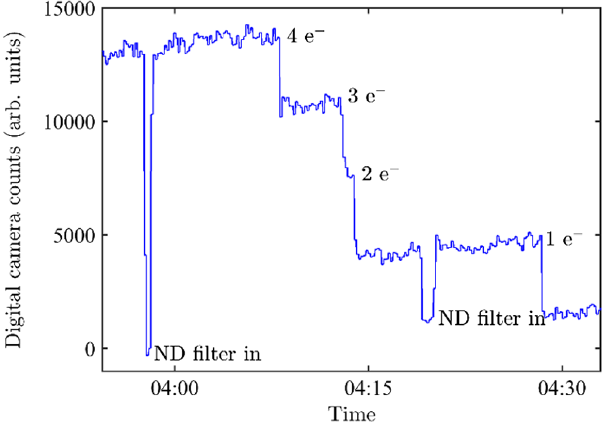
FIG. 3. OSR intensity in the west synchrotron light monitor (PAR:SLM1) versus run-time at 10-s sampling over ∼ 35 minutes at 375 MeV. The discrete intensity steps are at 3250 counts = e − . At 04 ∶ 19 , the ND filters were inserted briefly to show the background level while a single electron was stored. This electron was purposely lost at 04 ∶ 28